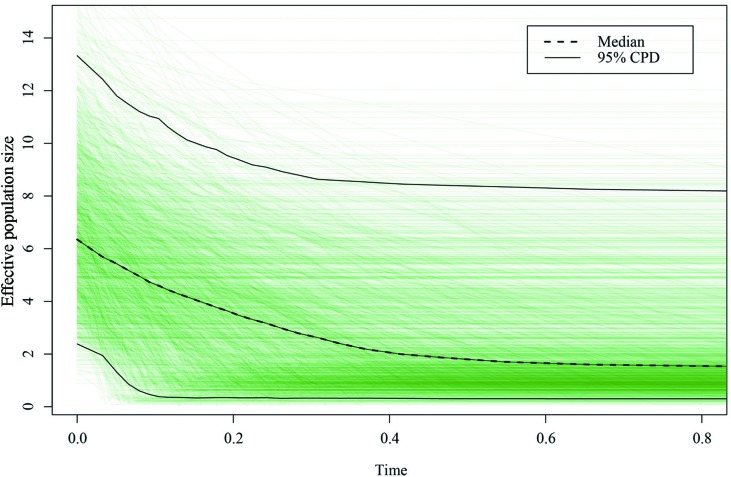
Extended Bayesian skyline analysis based on chloroplast DNA (cpDNA) of Pterocarya stenoptera. The x-axis represents the time before present (Ma) and the y-axis represents the effective population size. The dashed and solid lines indicate the median and 95% highest posterior density intervals, respectively.